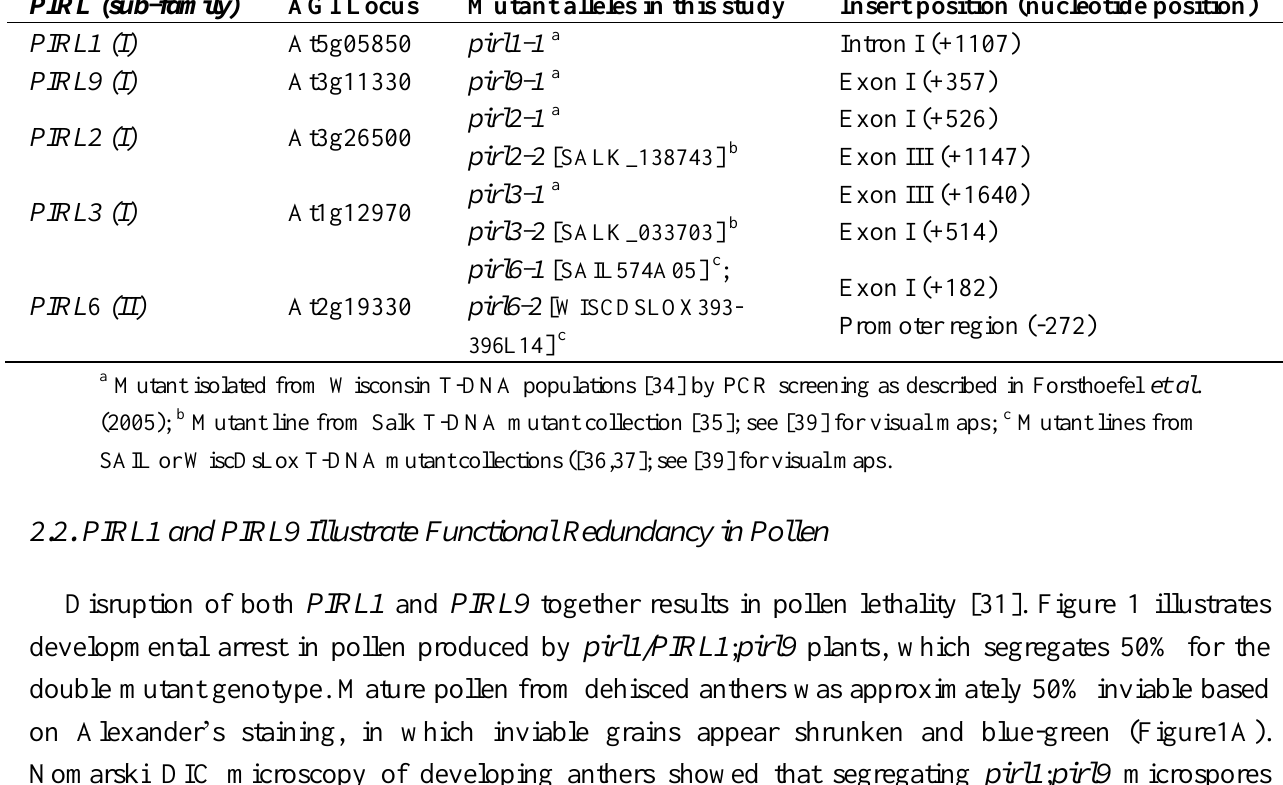
Table 1. Plant Intracellular Ras-group LRR (PIRL) genes and mutant alleles included in this study. PIRL (sub-family) AGI Locus Mutant alleles in this study Insert position (nucleotide